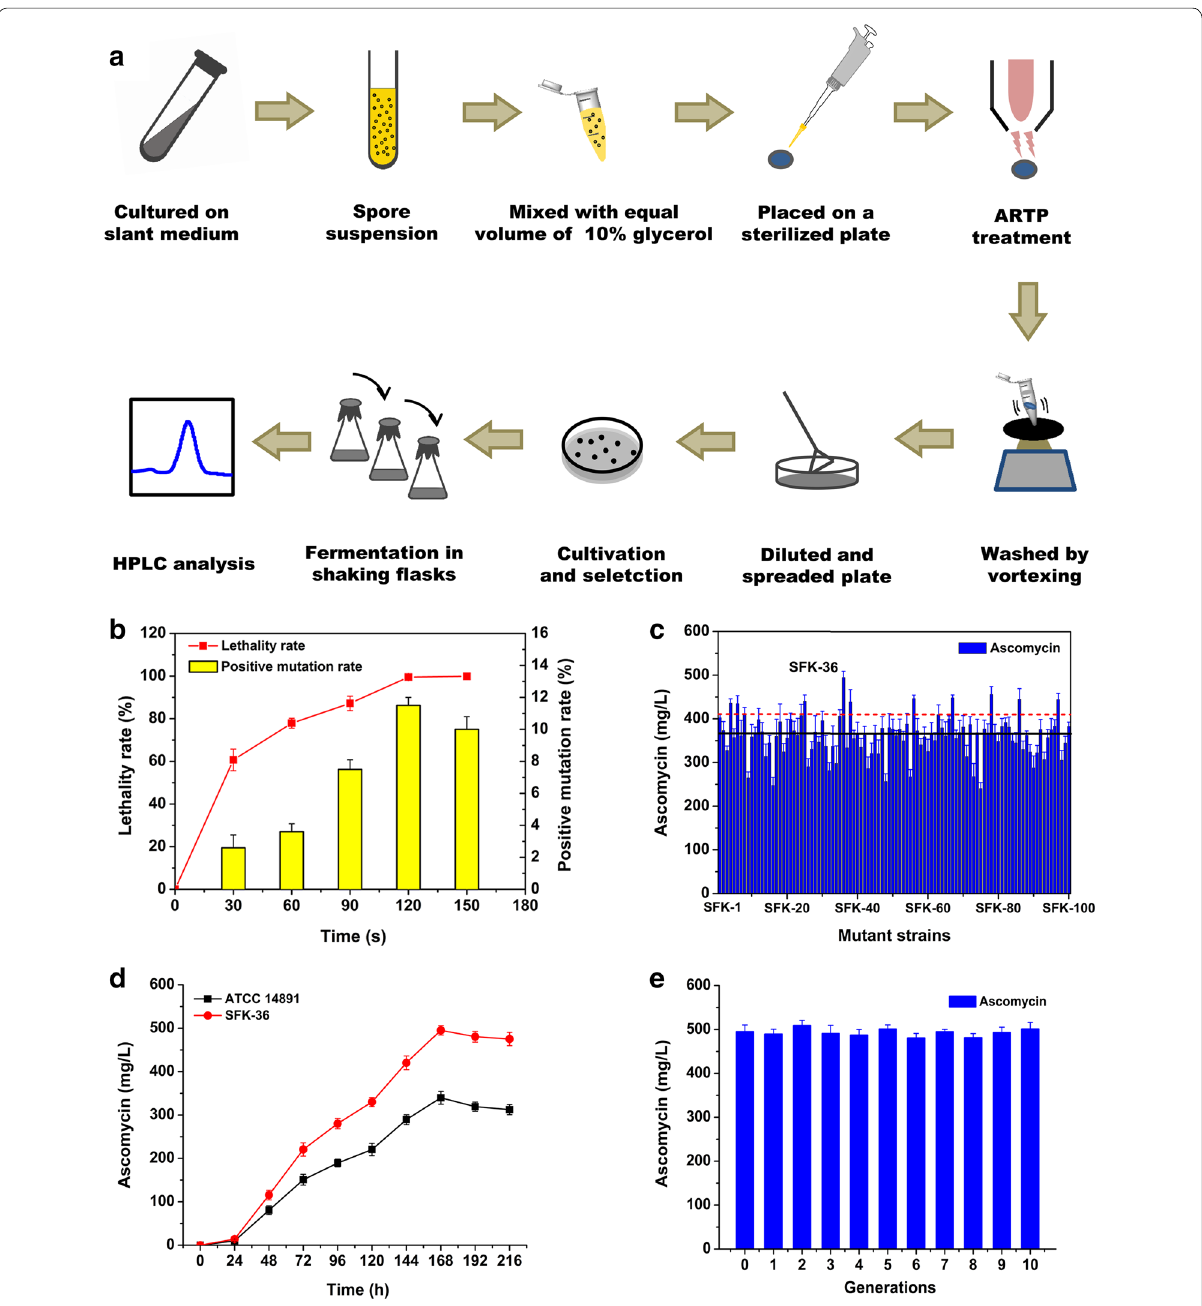
Fig. 1 ARTP mutagenesis breeding for S. hygroscopicus ATCC 14891 strain. a The experimental procedure of high-yield strain screening by ARTP breeding system. b Lethality rate and positive mutation rate of ATCC 14891 strain after ARTP mutagenesis. c Ascomycin production of the isolated mutants after ARTP mutagenesis (the black solid line represented 373.8 mg/L—the production of original ATCC 14891 strain, while the red dotted line was for the yield of positive mutant strains, in which ascomycin production was found to be over 10% higher relative to ATCC 14891 strain). d The comparison of ascomycin production between SFK-36 and ATCC 14891 in shake flask. e Genetic stability of SFK-36 in ascomycin production by natural